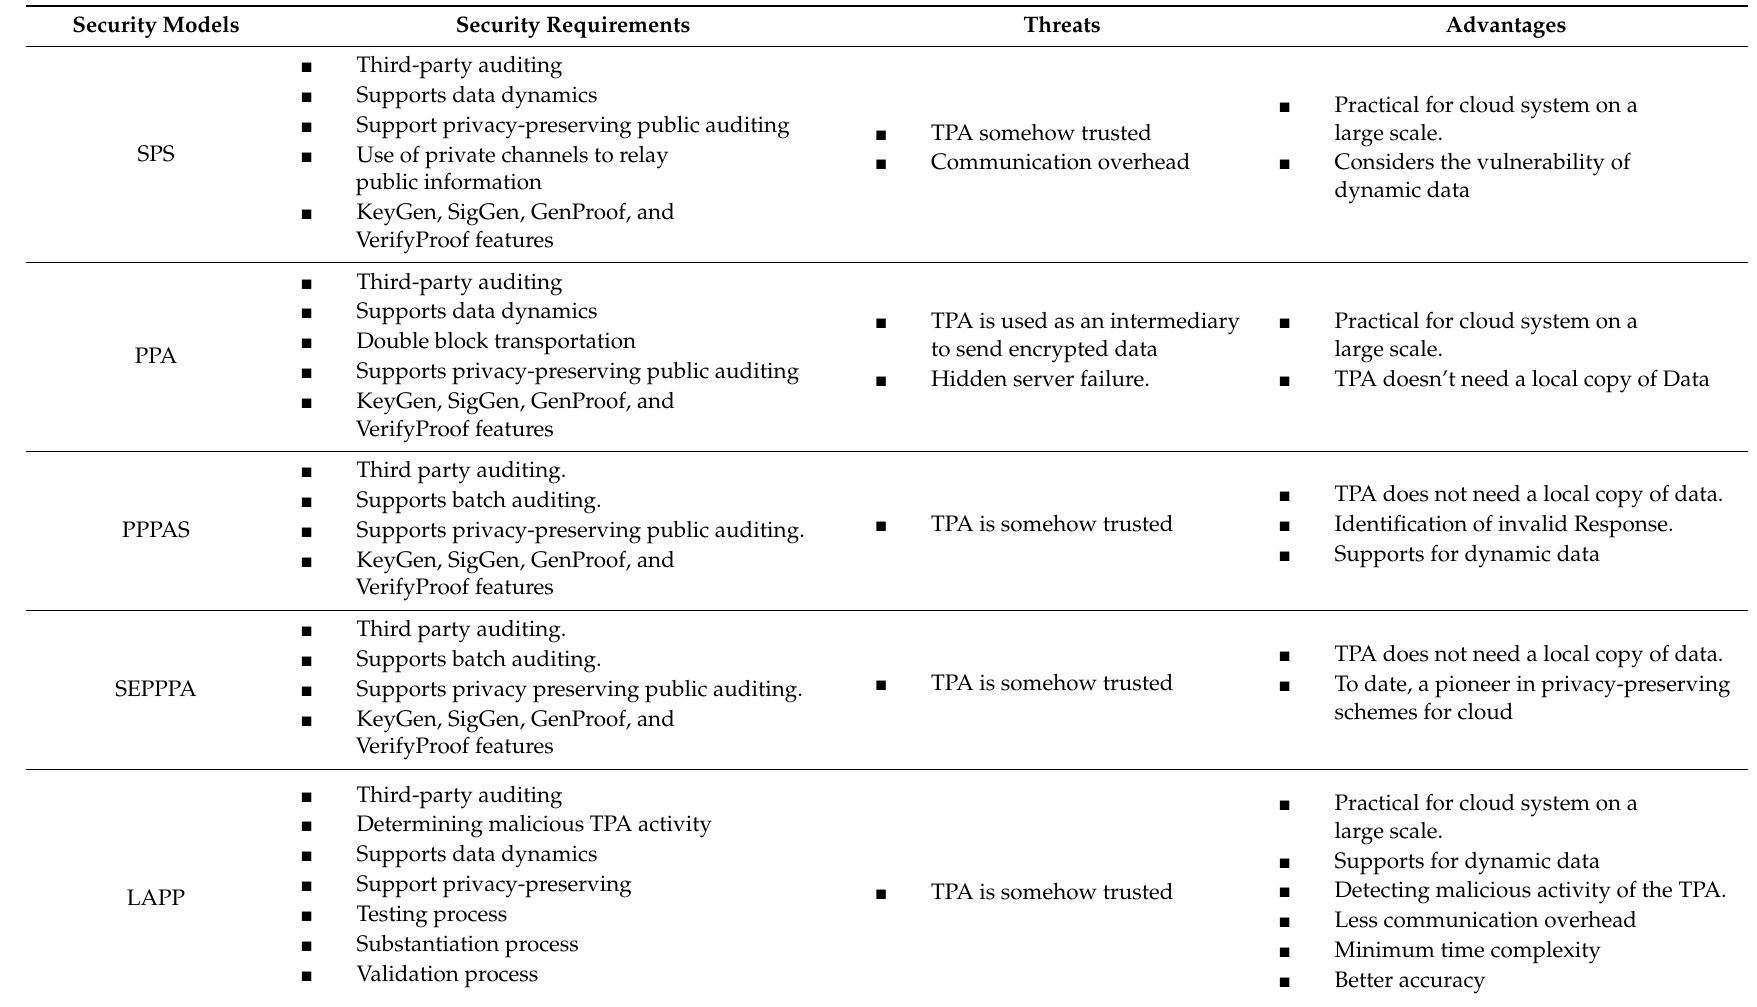
Table 3. Comparison of LAPP and competing